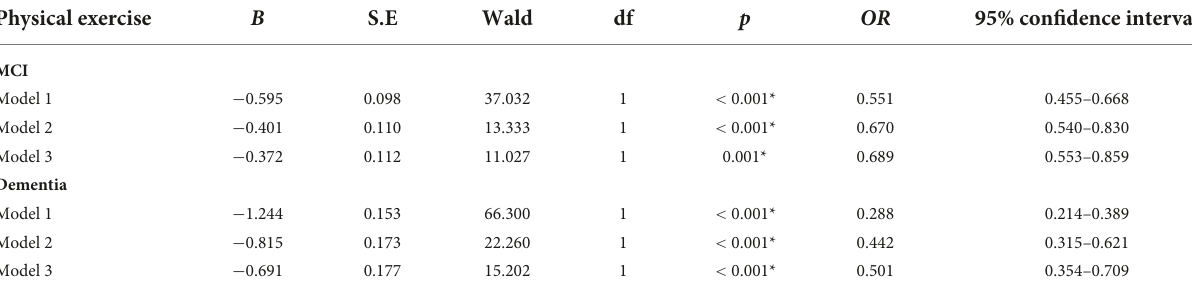
TABLE 2 Physical exercise (as categorical variable) and mild cognitive impairment/dementia.